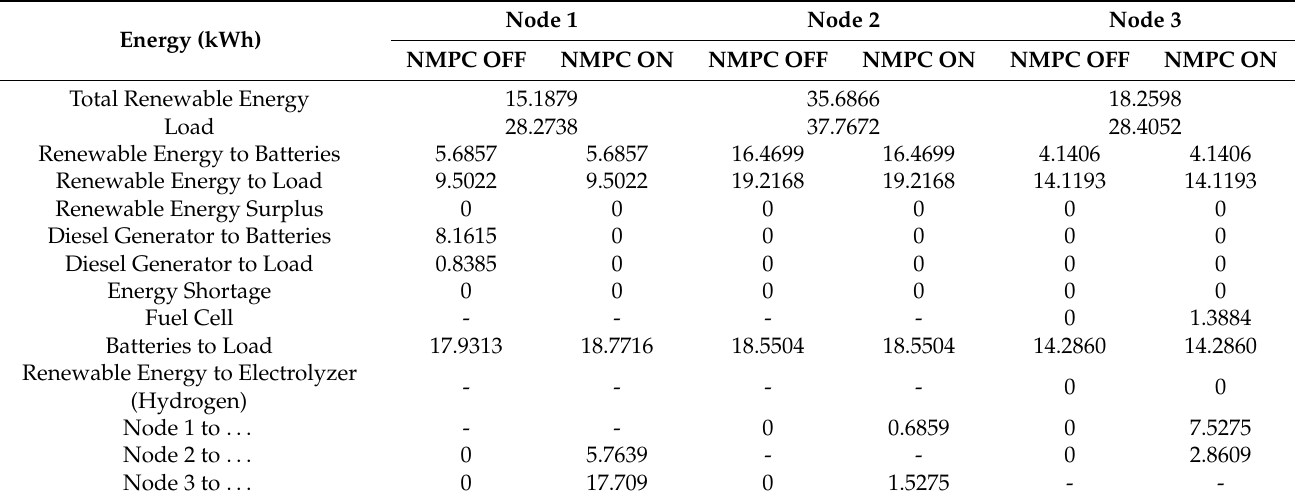
Table A2. Comparative results from Scenario 2—Daily operation with unpredicted weather and load conditions.